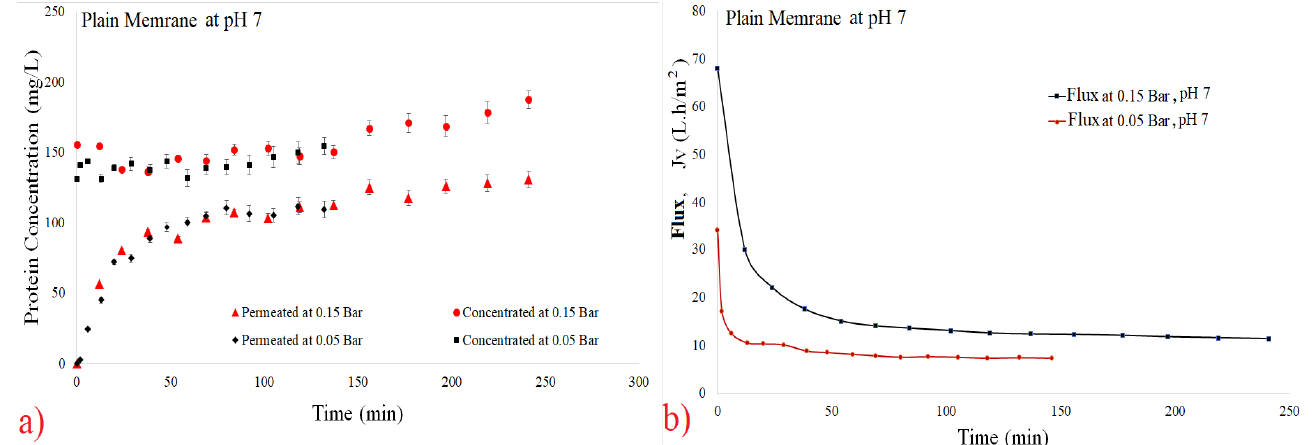
Figure 3. Effect of pressure on filtration flux of the 0.1 µm plain membrane at pH 7. ( a ) Total protein curves and ( b ) flux curves.